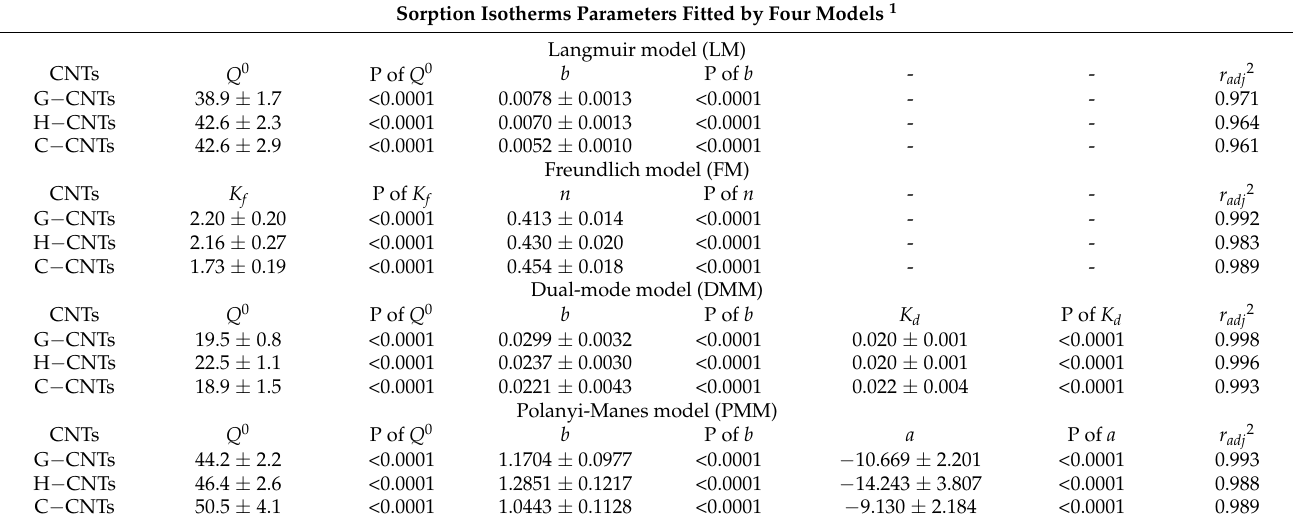
Table 1. Results of sorption models of nitrobenzene by the functionalized CNTs. Sorption Isotherms Parameters Fitted by Four Models